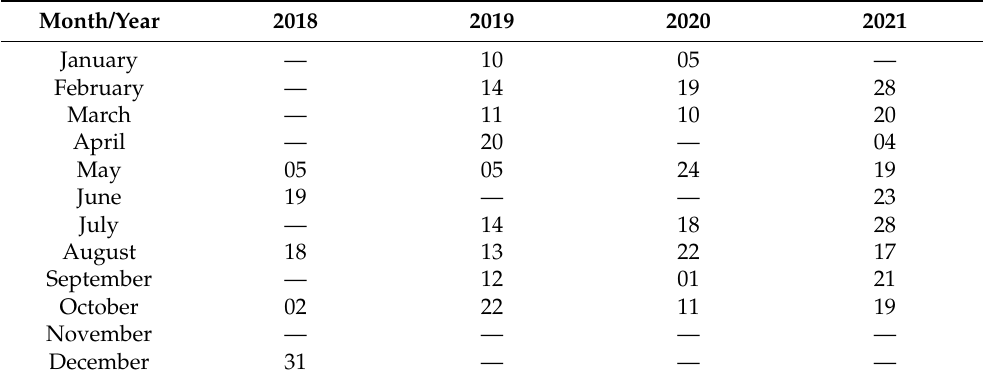
Table 1. Date (year, month, and day) of the Level-2A Sentinel-2 in the grid